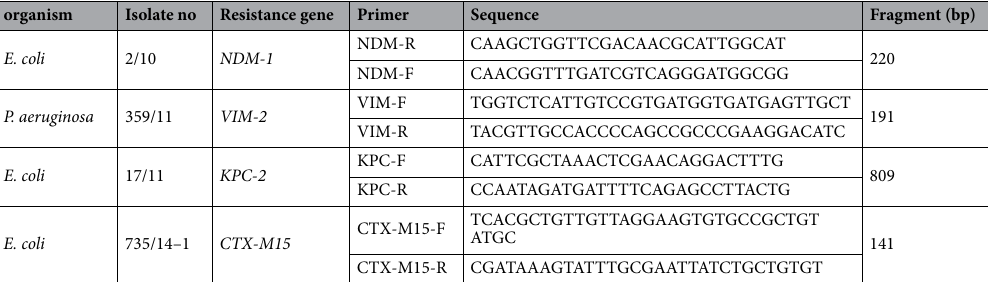
Table 1. List of organisms and primers. Illustration of the organisms used in this study including the target resistance gene and the RPA primers. The isolate number refers to the nomenclature of the german Robert Koch Institute. All primers were synthesized and provided by metabion international AG.